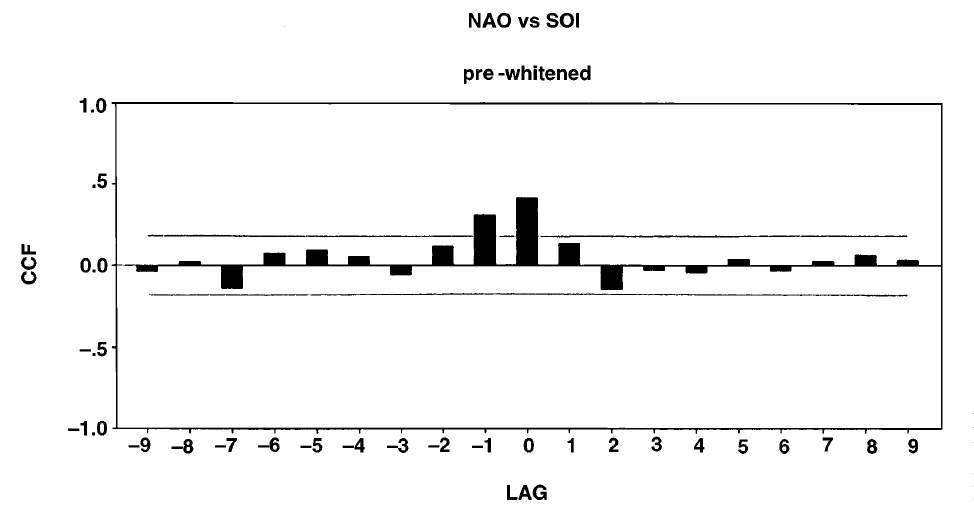
Fig. 5. Cross-correlations be- tween the 6–8 years RCS of SO and NAO for several lags (one lag = one